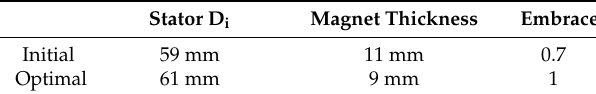
Table 6. Initial model and optimization model.